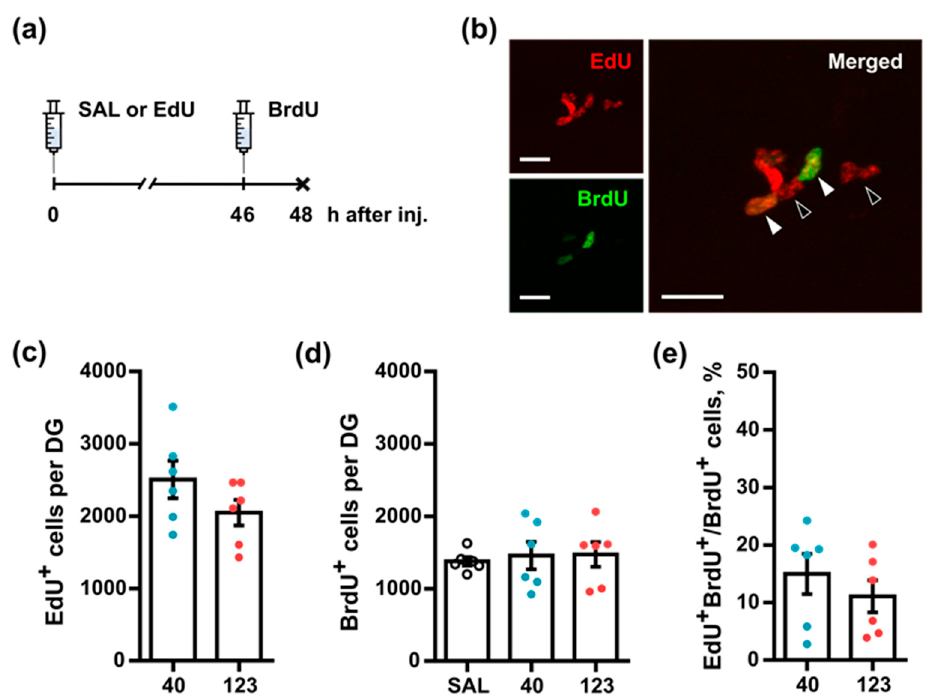
Figure 2. Single injection of EdU does not affect the survival and subsequent division of hippocampal neural precursor cells. ( a ) Scheme of injections. Either saline or EdU at different doses (40 or 123 mg/kg) was injected. BrdU at a dose of 50 mg/kg was injected 46 h later, as well as 2 h before euthanasia. ( b ) Representative images of EdU- and BrdU-labeled cells. Filled arrowheads indicate EdU + BrdU + cells, and empty arrowheads indicate EdU + BrdU - cells; the scale bar is 20 µ m. ( c ) Number of EdU + cells in the DG. ( d ) Number of BrdU + cells in the DG. ( e ) Number of EdU + BrdU + double-labeled cells, as a fraction of BrdU + cells. ( c , e ) Mann–Whitney U-test, ( d ) one-way ANOVA; no significant difference between groups was